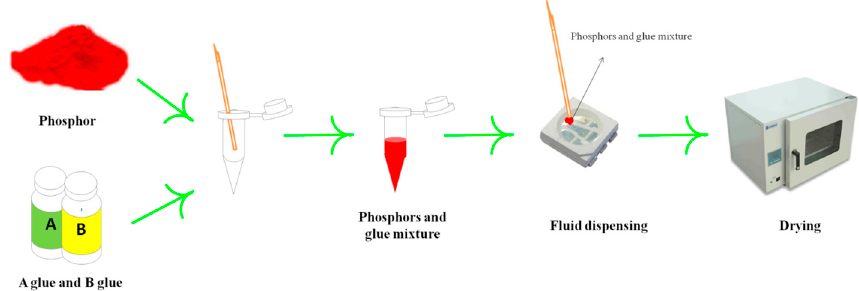
Figure 2. Preparation of the phosphor-converted light-emitting diodes (PC-LEDs) device.